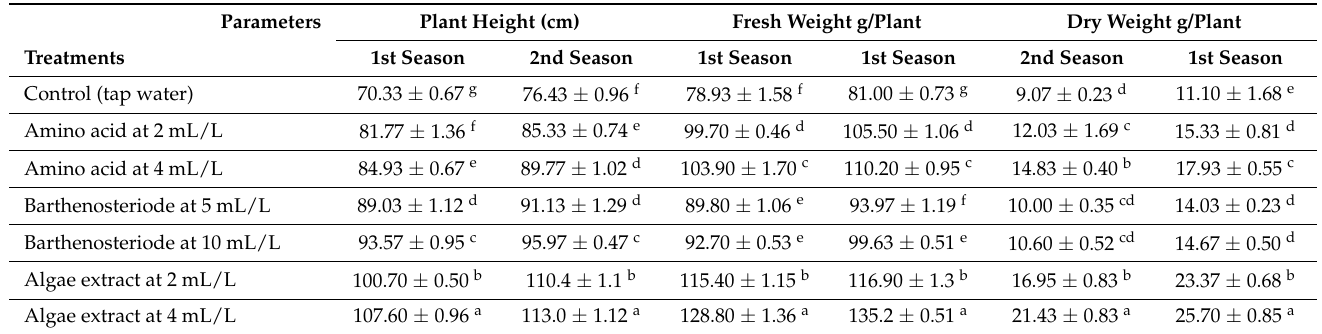
Table 2. Effect of bio-stimulant treatments on chia plant height (cm), fresh weight (g)/plant, and dry